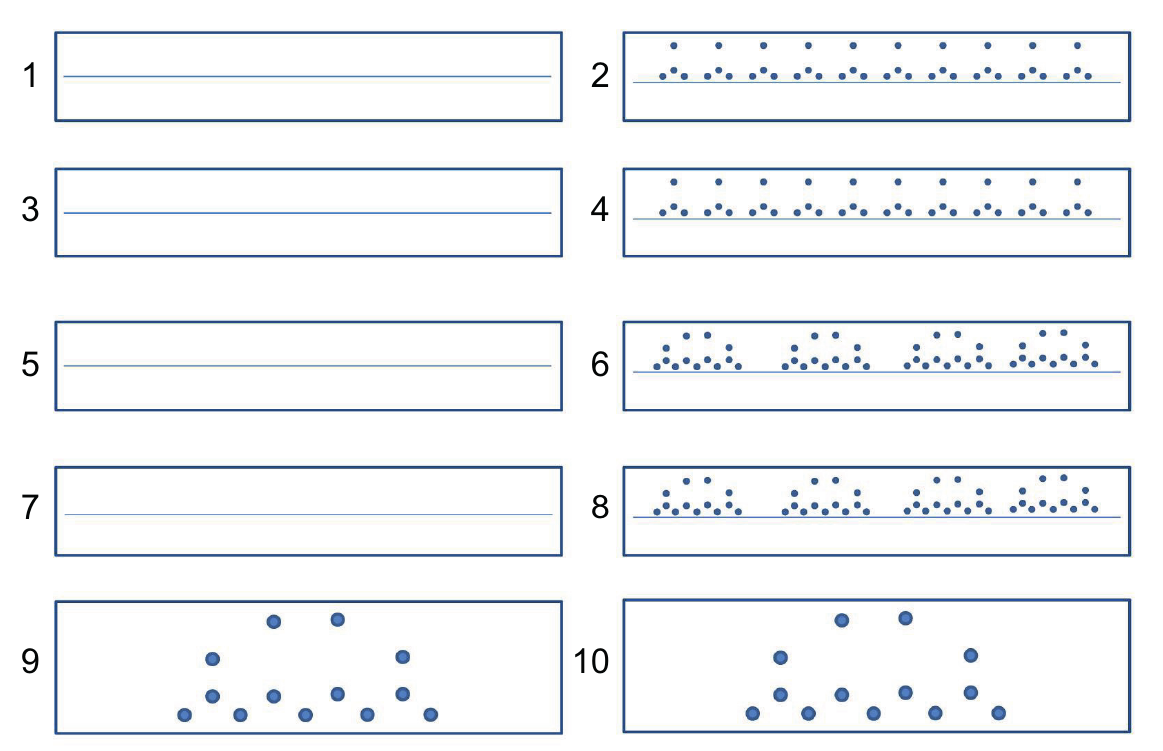
Figure 1. Horizontally oriented A4 sheet containing the boxes (dimensions 2 cm × 12 cm for 1–8 boxes, 3 cm × 12 cm for boxes 9 and 10) on which the participants had to perform the ten tasks. In 1–8 boxes the participants had to write on the central lines. Blue circles represent the visual cues that have to be reached for performing the task.